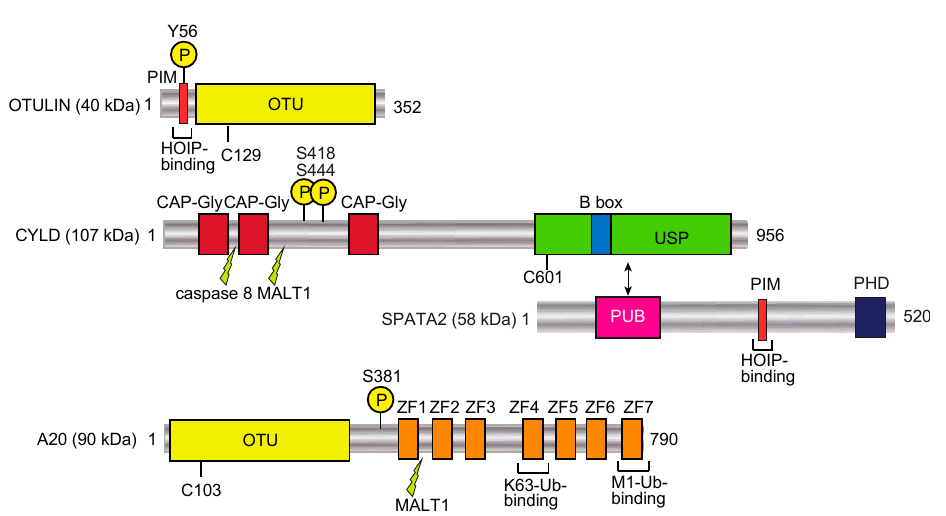
Figure 3. DUBs involved in the regulation of the linear ubiquitin code. Domain structures and functions of LUBAC-regulating factors, such as OTULIN, CYLD-SPATA2, and A20, are shown. PIM, PUB domain-interacting motif; OTU, ovarian tumor protease; CAP-Gly, cytoskeleton-associated protein Gly-rich domain; B box, B-box-type zinc finger domain; PUB, PNGase / UBA or UBX; PHD, plant homeodomain; ZF, zinc finger. Phosphorylation sites are denoted by encircled Ps, and caspase 8 and MALT1 cleavage sites are also indicated.